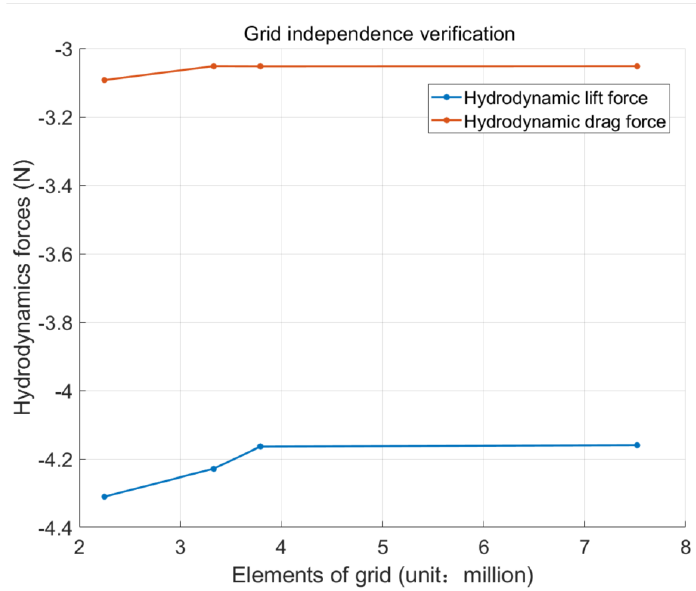
Figure 6. Grid independence verification.